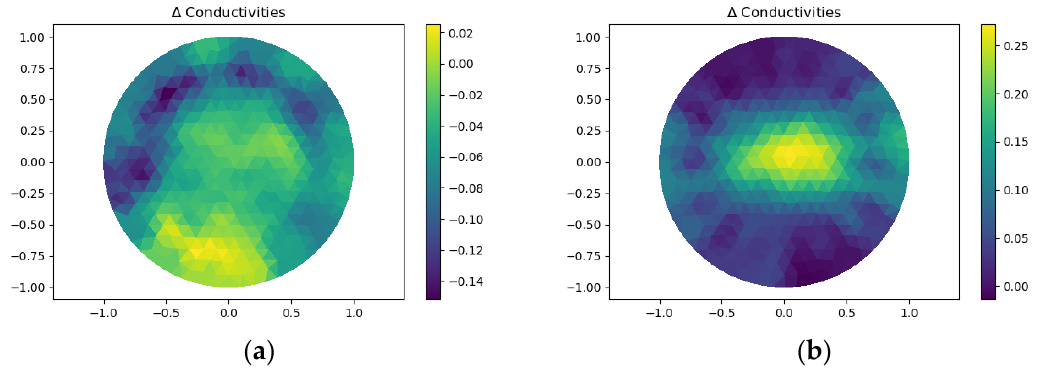
Figure 7. ( a ) Reconstructed image of single-layer structure sensor; ( b ) Reconstructed image of double-layer structure sensor.